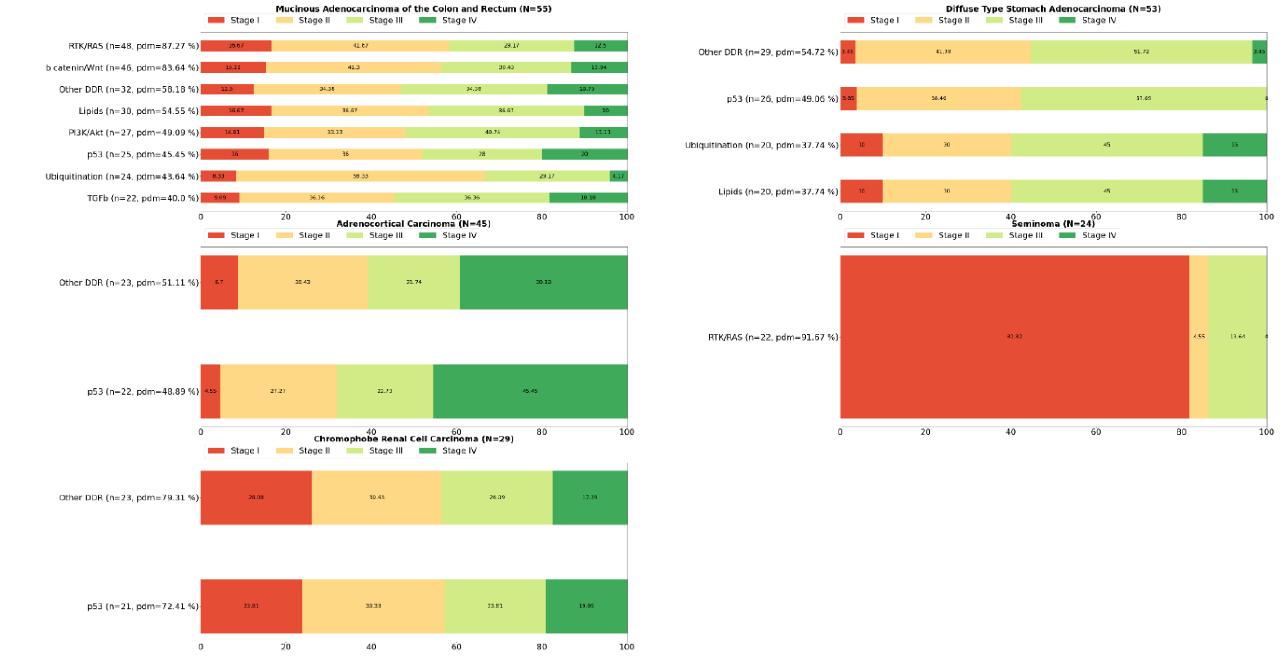
Figure 2. Crucial signaling pathways implicated in 25 cancer types/subtypes per disease stage. For this analysis, 5283 tumor samples with an available mutational profile and disease stage were examined. Here, only signaling pathways altered in at least 20 of the examined samples for each cancer type/subtype are shown. N: number of samples examined; n: number of samples that harbor somatic driver mutations in each signaling pathway; pdm: proportion of samples of a particular cancer type/subtype that harbor at least one somatic driver mutation in genes of a particular signaling pathway.